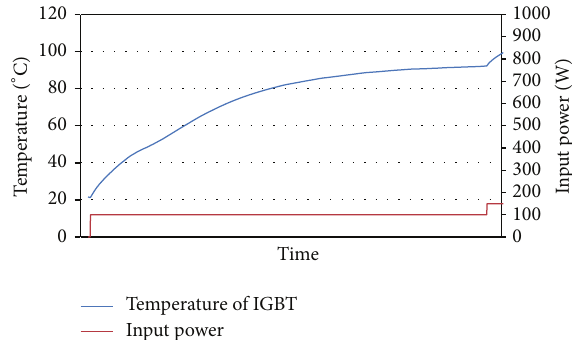
Figure 10: Dependence of temperature on input power of IGBT cooled by LHP with third variant of wick structure.